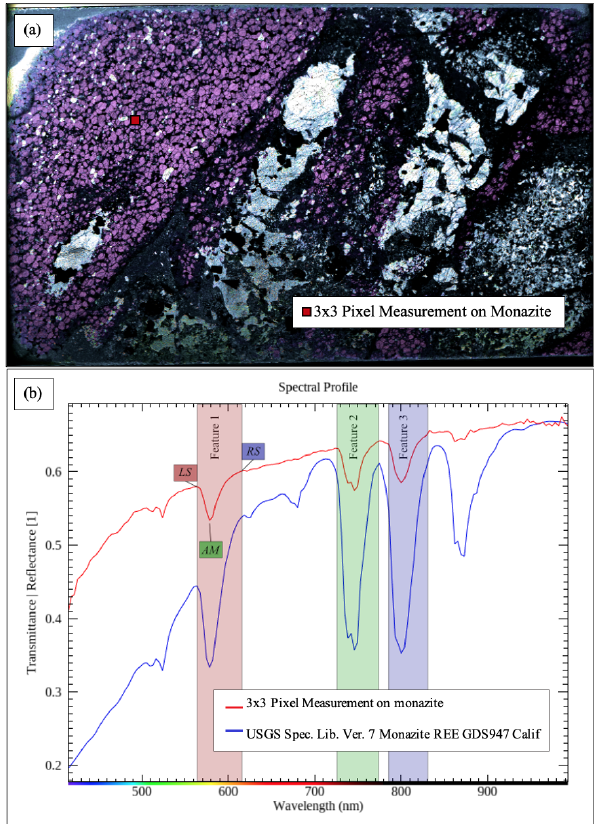
Figure 3. (a) False color (saturation 300%) hyperspectral transmit- tance image of the thin section to highlight the monazites by the first Nd absorption feature (Feature 1 in b ) at R: LS: 563.91nm; G: AM: 578.46nm; and B: RS: 618.46nm. (b) Comparison between the measured spectral signatures of a 3 × 3 pixel area on a mon- azite and a measured monazite from the USGS Spectral Library (modified based on Kokaly et al., 2017). The three main absorp- tion features of Nd are highlighted, and the left shoulder (LS), the absorption maximum (AM), and the right shoulder (RS) of the first feature are